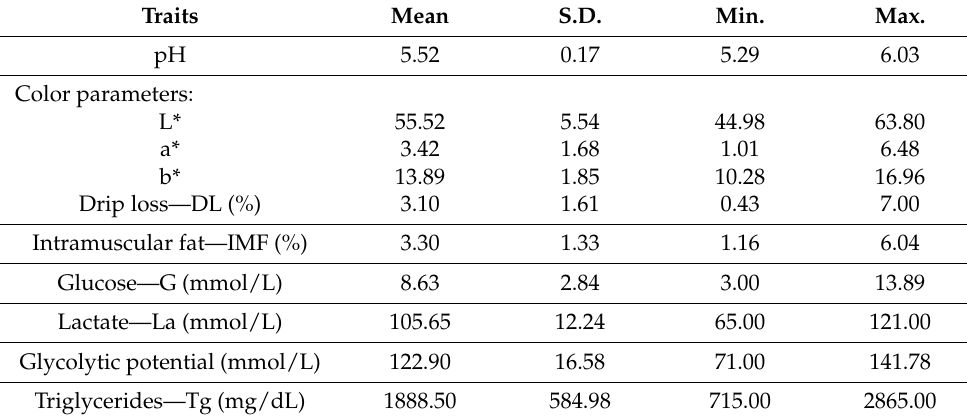
Table 1. Characteristics of studied